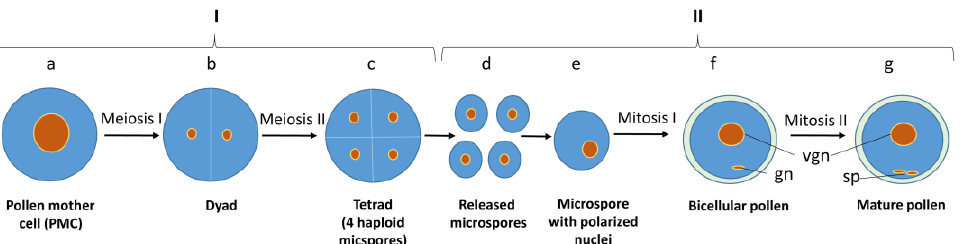
Figure 2. Schematic diagram illustrating pollen development in plants. Pollen development occurs in anthers located within a flower. Phase I is microsporogenesis and phase II is microgametogenesis. During microsporogenesis, the PMC ( a ) undergoes meiosis ( b ) and four haploid spores are produced ( c ). Microgametogenesis begins with releasing the microspores ( d ), followed by polarization of nuclei in the microspores ( e ). After the first mitosis, bicellular pollen develops ( f ) and contains vegetative (vgn) and generative nuclei (gn). Next, mitosis of generative nuclei leads to the development of mature pollen ( g ) with vegetative nuclei and two sperm cells (sp).